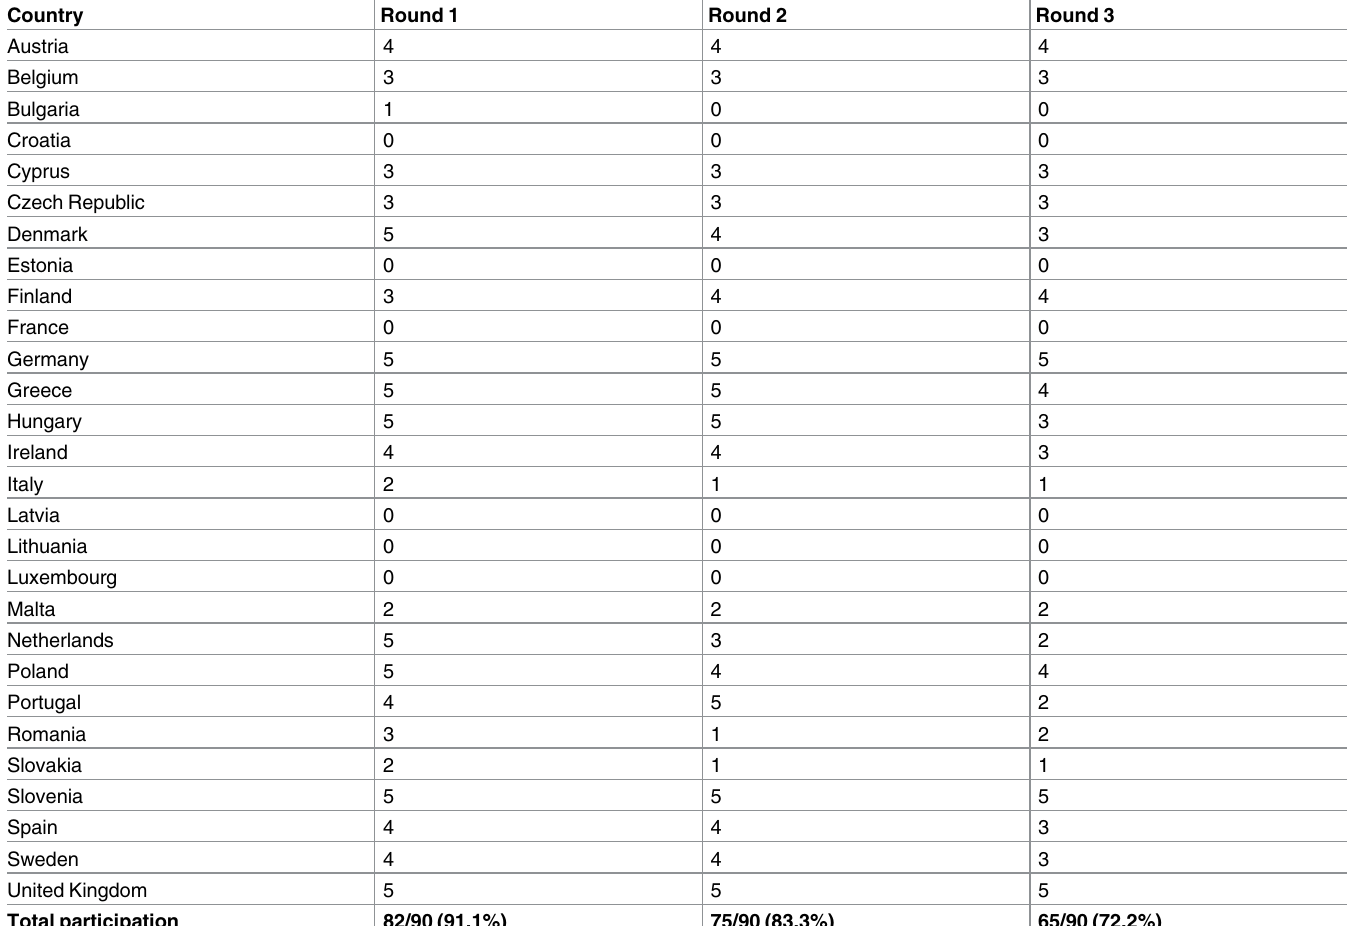
Table 1. Panel member participation in each of the three Delphi rounds.